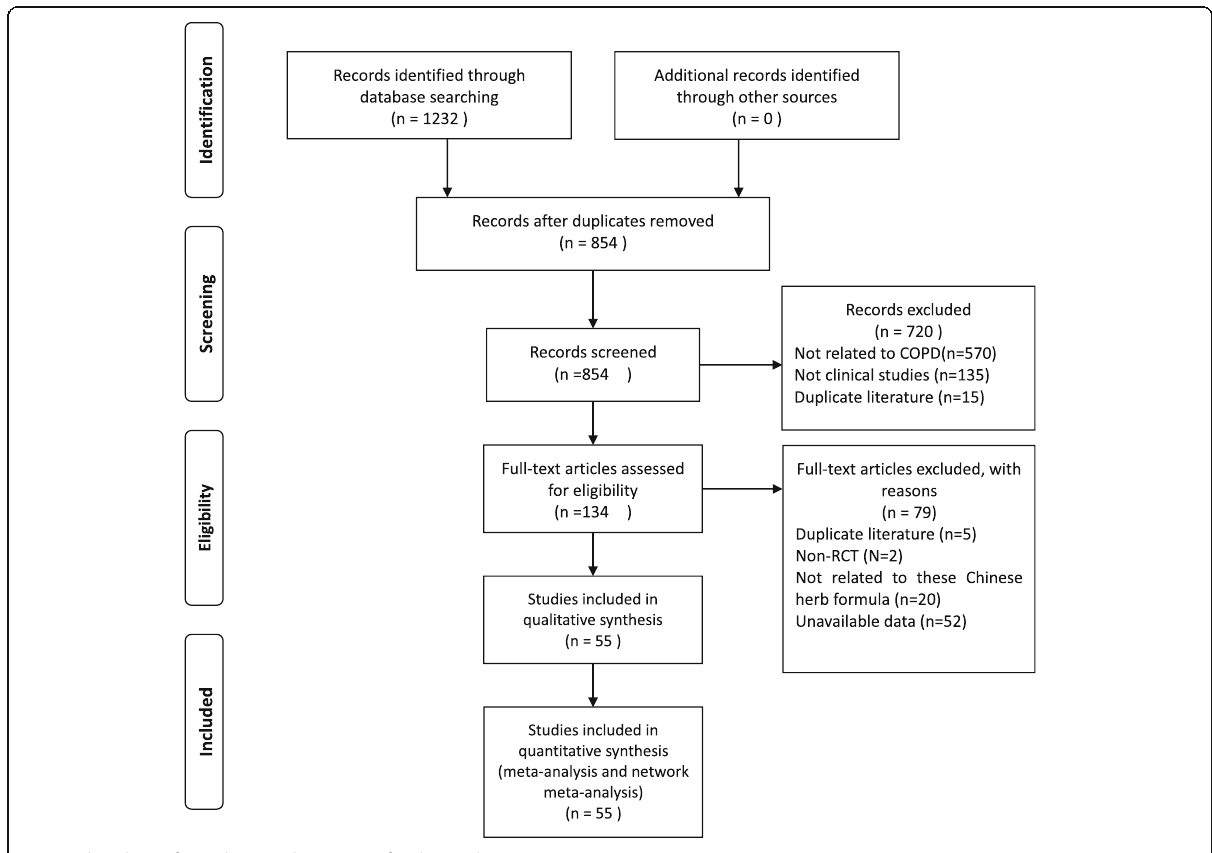
Fig. 1 Flowchart of searching and screening for the